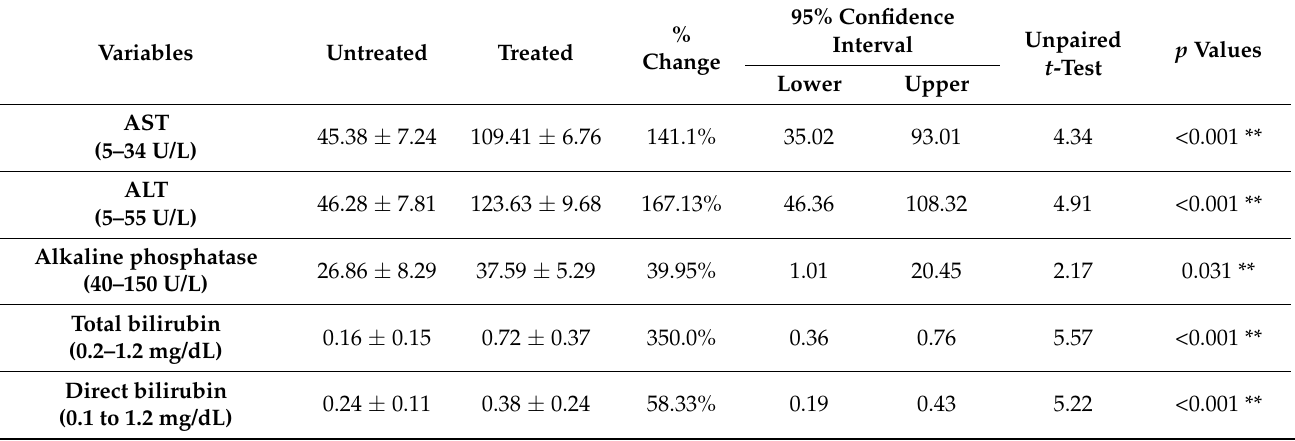
Table 5. Comparison between treated and untreated after FPV